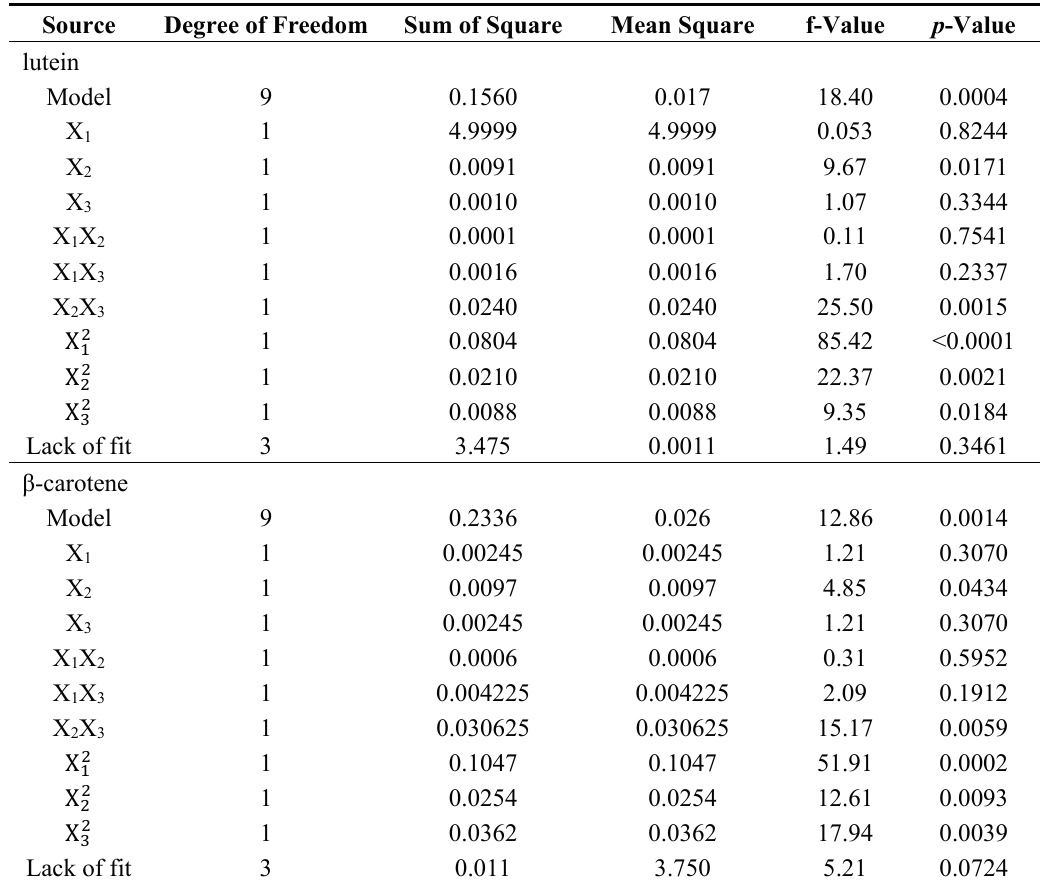
Table 2. Analysis of variance results for the multiple regression to predict lutein and β